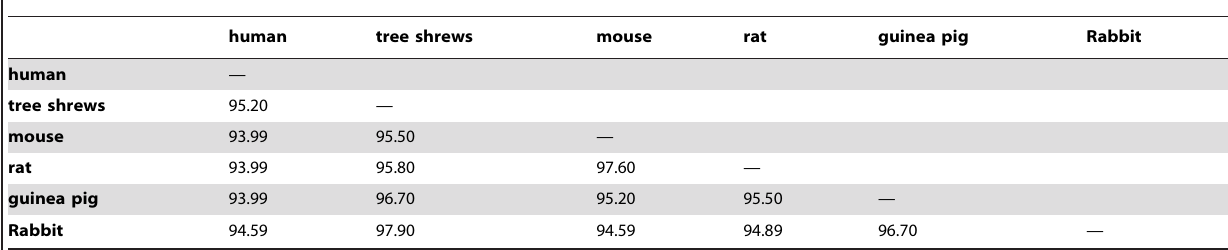
Table 1. MSA Scores of GAPDH.